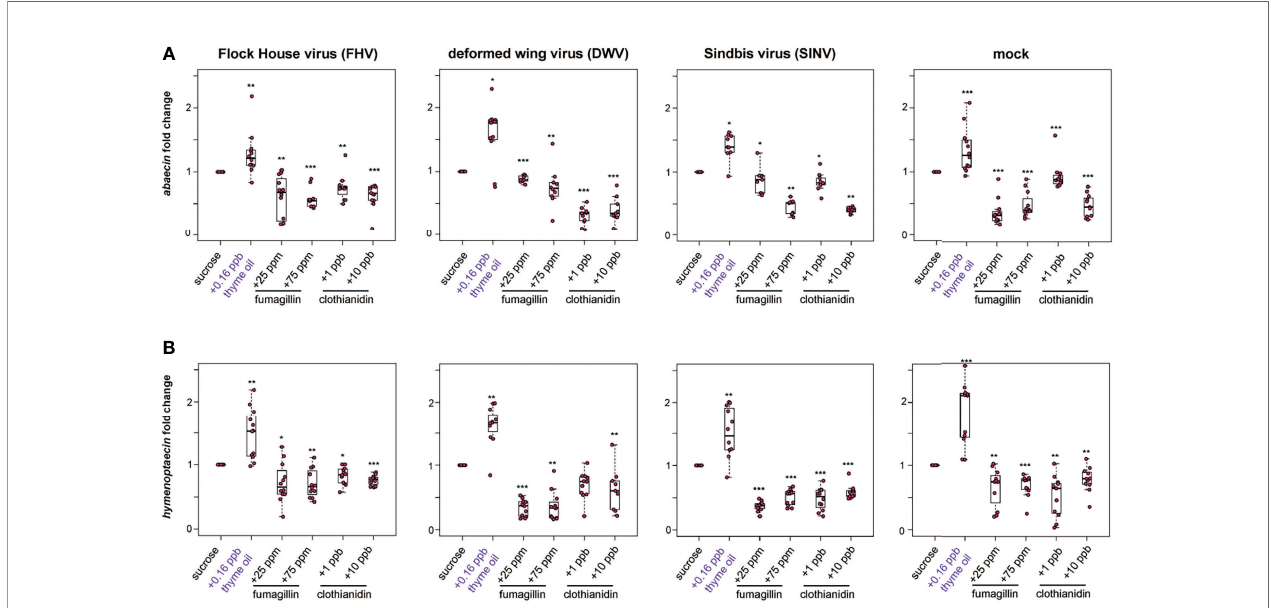
FIGURE 3 | Expression of key RNAi genes was higher in honey bees fed thyme oil augmented sucrose syrup and lower in bees fed sucrose syrup containing fumagillin or clothianidin. Expression of dicer-like and argonaute-2 in honey bees that were either mock- or virus-infected (i.e., FHV, DWV, SINV) and fed sucrose syrup only or syrup containing either thyme oil (0.16 ppb), fumagillin (25 ppm or 75 ppm), or clothianidin (1 ppb or 10 ppb) was assessed by qPCR. The DD Ct method with normalization to rpl8 in mock or virus-infected bees fed sucrose syrup diet was utilized to determine the relative gene expression. (A) Dicer-like (dcr-like) expression was higher in virus-infected (i.e., FHV, DWV, SINV) and mock-infected bees fed thyme oil containing sucrose syrup, and lower in bees fed sucrose syrup containing fumagillin (25 ppm or 75 ppm) or clothianidin (1 ppb or 10 ppb) relative to bees fed sucrose syrup. (B) Argonaute- 2 ( ago2) expression was higher in virus- infected (i.e., FHV, DWV, SINV) or mock-infected bees fed thyme oil augmented sucrose syrup and reduced in bees fed diets containing fumagillin (25 ppm or 75 ppm) or clothianidin (1 ppb or 10 ppb), except in mock-infected bees fed 75 ppm fumagillin, ago2 expression was similar to expression levels in bees fed sucrose only. Data were analyzed by a pairwise Wilcoxon Rank Sums with a Benjamini – Hochberg correction for multiple comparisons. Asterisks indicate a signi fi cant change in gene expression compared to sucrose only control; signi fi cance levels: * p < 0.05; ** p < 0.005; *** p < 0.0005. This fi gure shows representative biological replicate for each gene (i.e., rep2 for dcr-like and rep3 for ago2 ). The data for all three biological replicates are presented in Supplemental Figures S4 , S5 . Raw data are included in Supplemental Tables S7 – S10